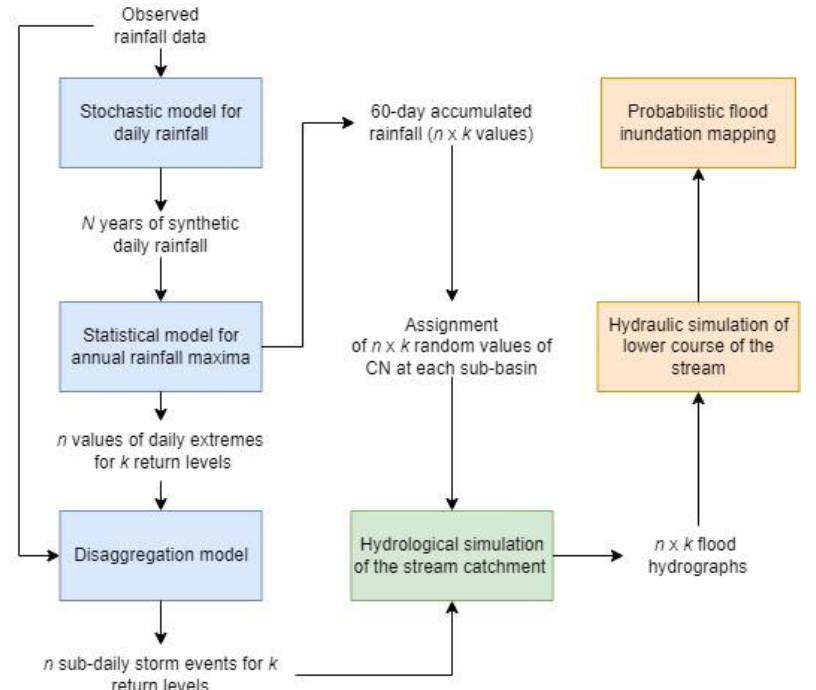
Figure 1. Cascade of models and exchange of input and output data within the hybrid stochastic simulation framework. In the present study, we use 𝑁 = 10,000 , 𝑛 = 100 and 𝑘 = 10 .